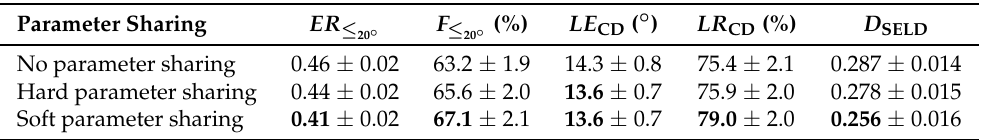
Table 4. Performance for different parameter-sharing methods in the encoder of our DCMA-SELD on the TNSSE 2021 development dataset. All data represent mean values and associated 95% confidence intervals. The highest performance in each metric is indicated in